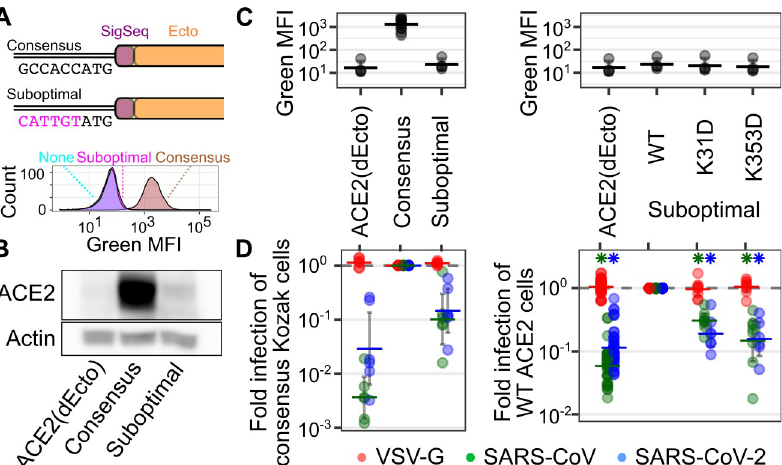
Fig 3. Tuning of ACE2 cellular abundance using suboptimal Kozak sequences. A) (Top) Schematic of consensus and suboptimal Kozak sequences preceding the ACE2 coding region. (Bottom) Representative flow cytometry smoothed histograms of negative control cells, or cells expressing WT ACE2 encoded behind a consensus or suboptimal Kozak sequence, stained with SARS-CoV-2 RBD-sfGFP. B) Representative Western blot showing the differences in total ACE2 protein abundance in engineered cells. C) Cell surface staining using SARS-CoV-2 RBD- sfGFP for cells with contrasting Kozak sequences (left), or encoding ACE2 variants (right). n = 4 or more, error bars denote 95% confidence intervals. D) Pseudovirus infection of cells with contrasting Kozak sequences (left), or encoding ACE2 variants in the context of a suboptimal Kozak (right). n = 6 or more, error bars denote 95% confidence intervals. Asterisks denote samples that exhibited a p-value less than 0.01 in a one-sample T-test from the infection value of